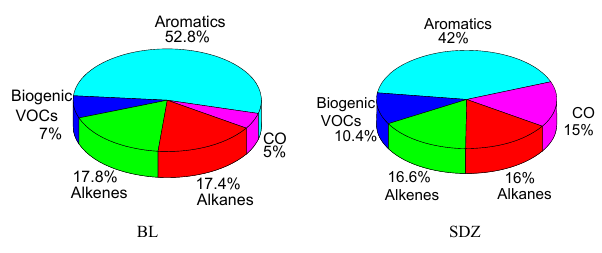
Fig. 6. Percentage contributions of alkanes, alkenes, biogenic Fig.6 Percentage contributions of alkanes, alkenes, biogenic VOCs, aromatics and carbon 2 VOCs, aromatics and carbon monoxide to total OFP at BL (left, to- monoxide to total OFP at BL (left, total OFP: 1451.2 μ gm − 3 ) and SDZ (right, total OFP: 375.9 3 tal OFP: 1451.2µgm − 3 ) and SDZ (right, total OFP: 375.9µgm − 3 ) . μ gm − 3 ). 4 very reactive aromatic species can be largely consumed